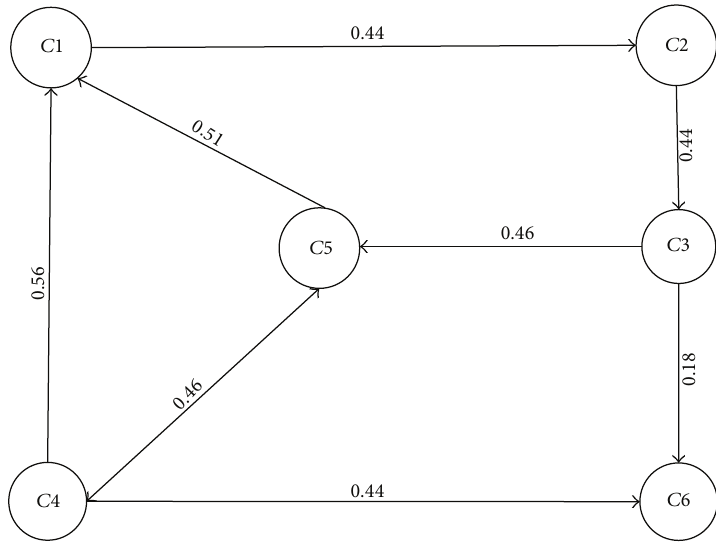
Figure 5: Weighted digraph of a gas pipeline network.